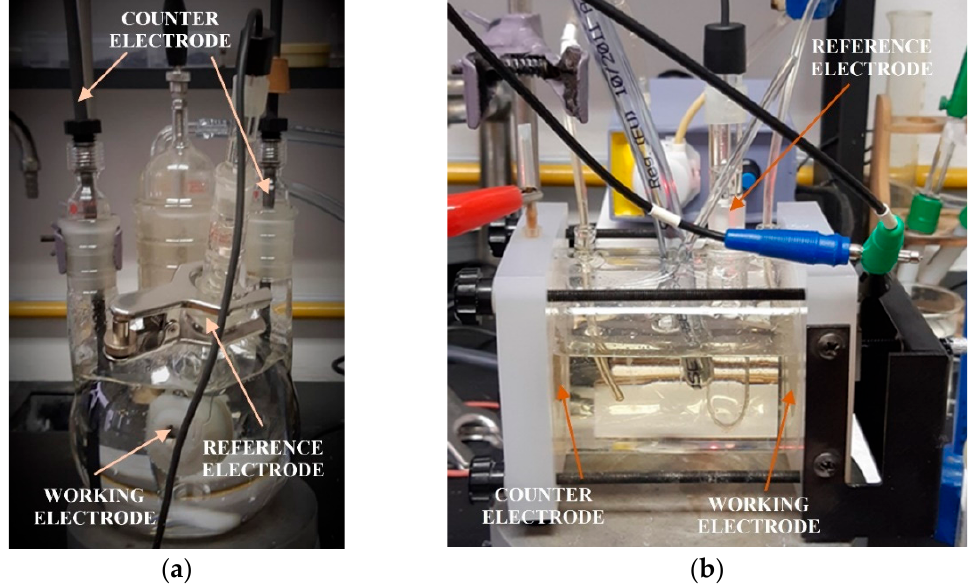
Figure 1. Three-electrode corrosion cell ( a ) for static conditions (Adapted from [23]); ( b ) for flow conditions (Adapted from [24]).